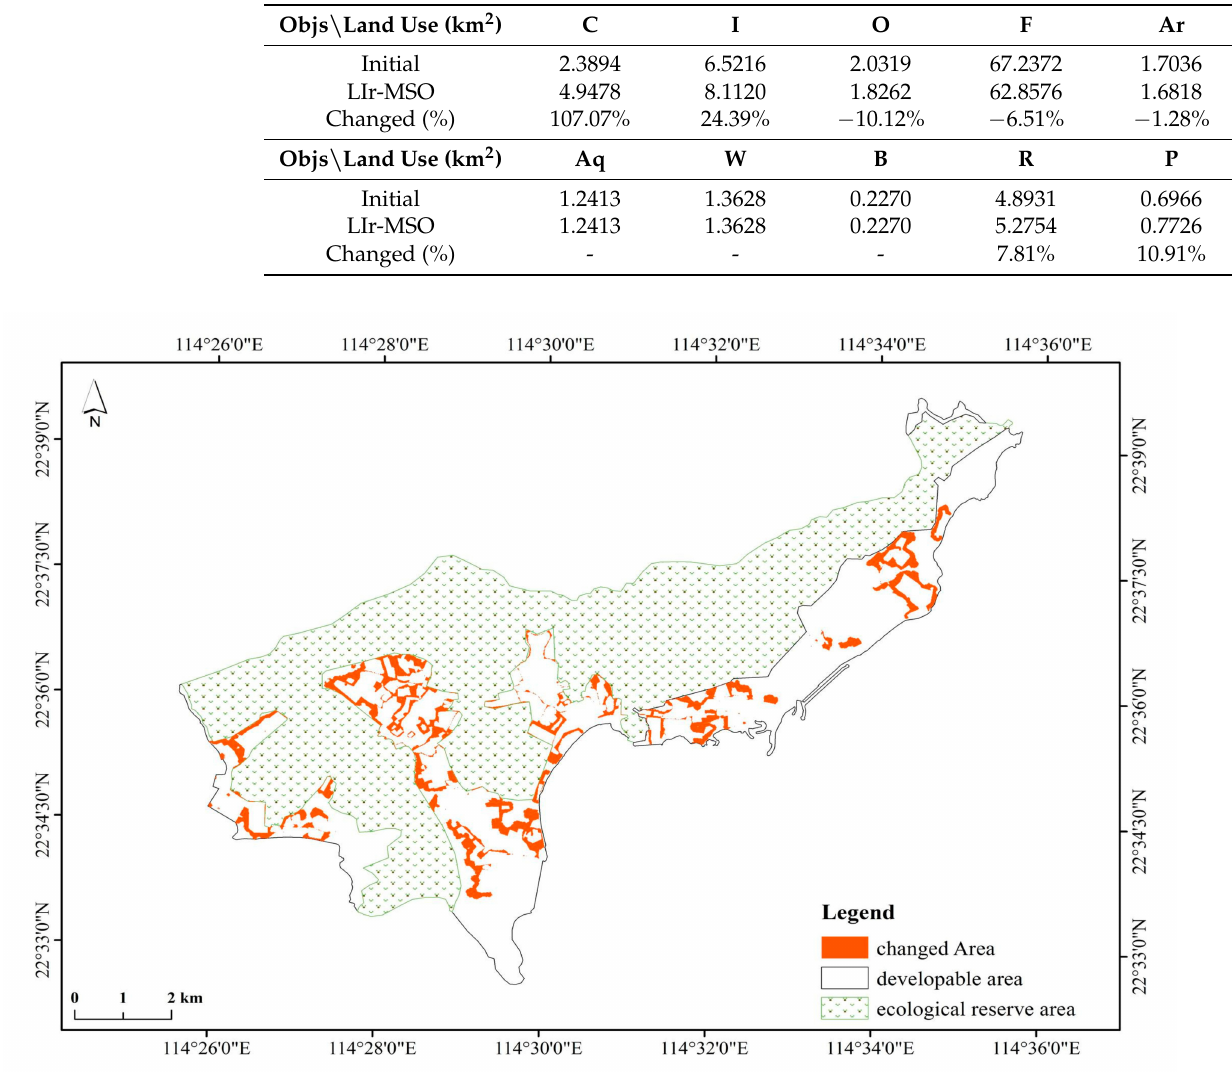
Table 5. Comparison of the change in area (km 2 ) between initial pattern and optimal multi-objective optimal pattern for the different land uses. Abbreviations are described in Table 1.